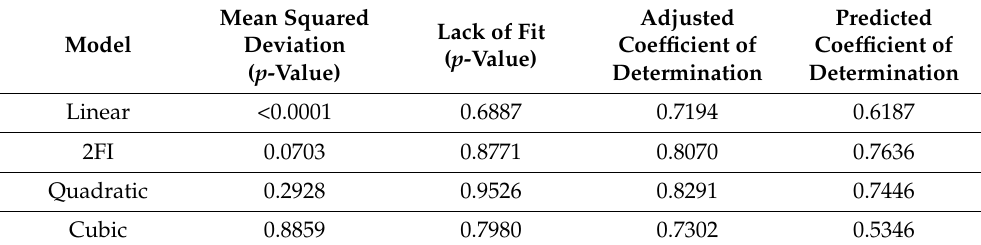
Table 10. Simulation of the four models in Design Expert penetration.